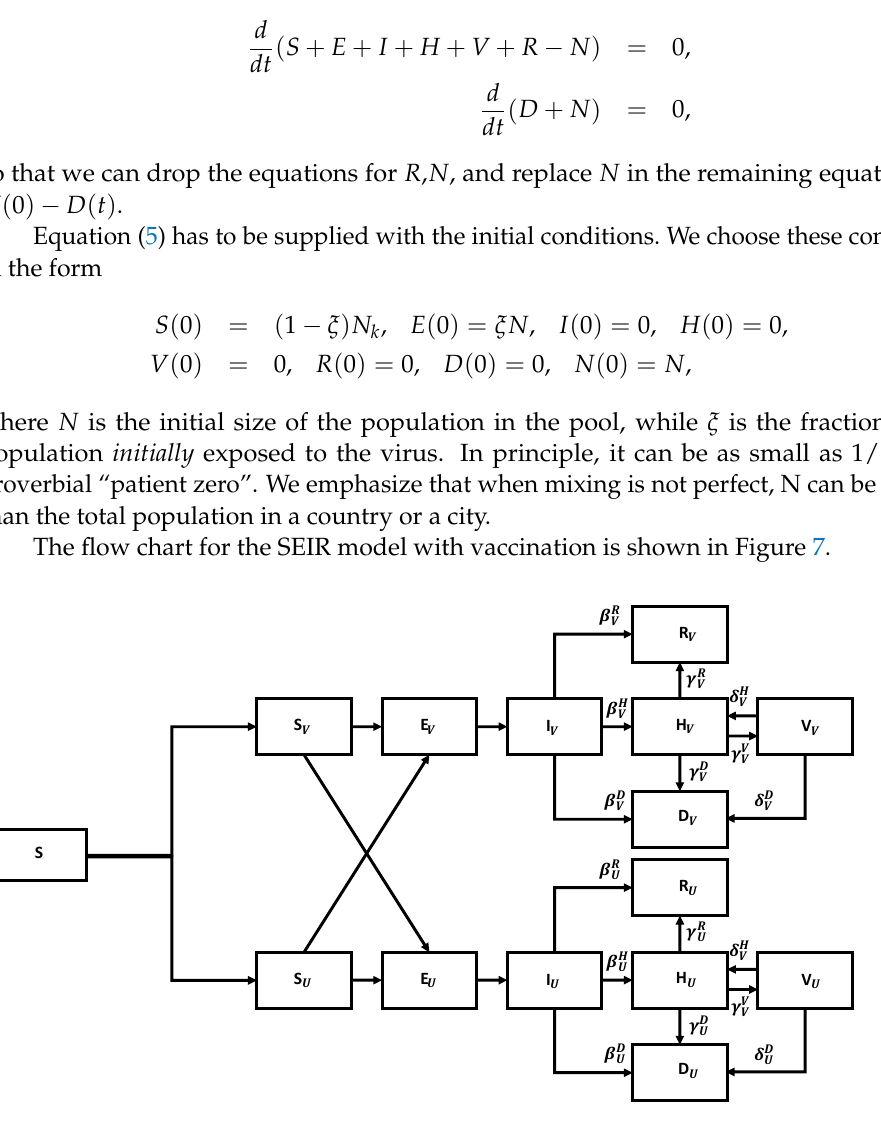
Figure 7. Flow chart for the SEIR model with